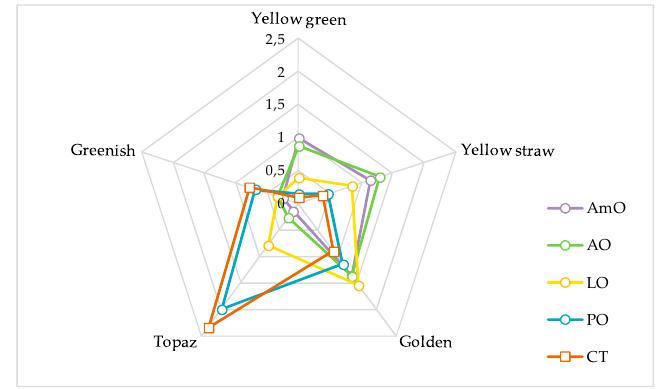
Figure 3. Color profile based on the average panel score’s attributes of the wine spirits aged four years in different kinds of wood. For each color attribute, the differences between the aged wine spirits are very significant ( p < 0.01). Adapted from [23].